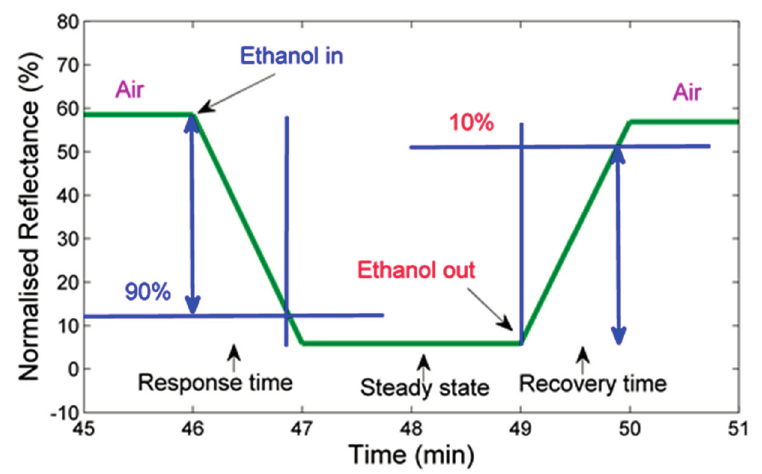
Figure 9. Dynamic response curve showing response and recovery time